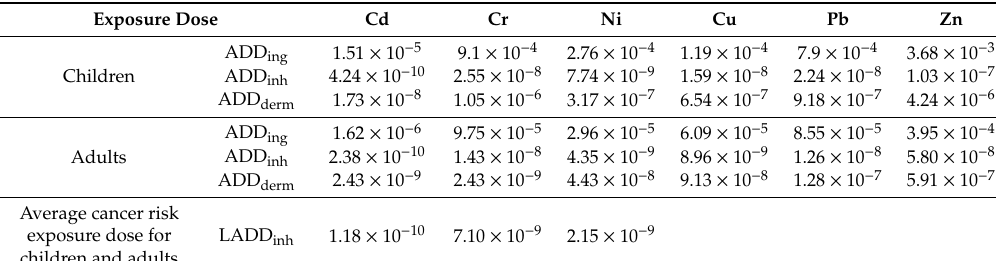
Table 3. Exposure doses of heavy metals in atmospheric deposition (mg / (kg ·